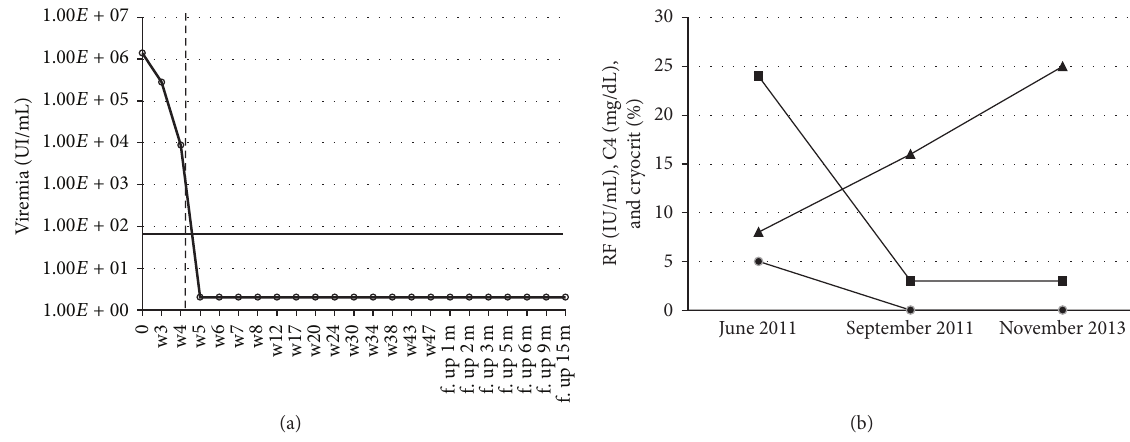
Figure 1: (a) Viral kinetics: a slight decrease in serum HCV RNA values was observed during the lead-in phase. Soon after the introduction of boceprevir (week 4), a drastic reduction in viremia was observed, with complete negativization at week 5. The vertical dashed line represents the introduction of boceprevir; the horizontal continuous line indicates the detection limit of the HCV RNA test (15IU/mL). IU: international units; mL: milliliter; w: week; f. up: follow up; m: month. (B) Cryocrit C4 and RF kinetics during the combined therapy (RTX+Peg- IFN+RBV+BOC). The time points considered are (1) before rituximab (June 2011), (2) two months after rituximab cycle (September 2011;